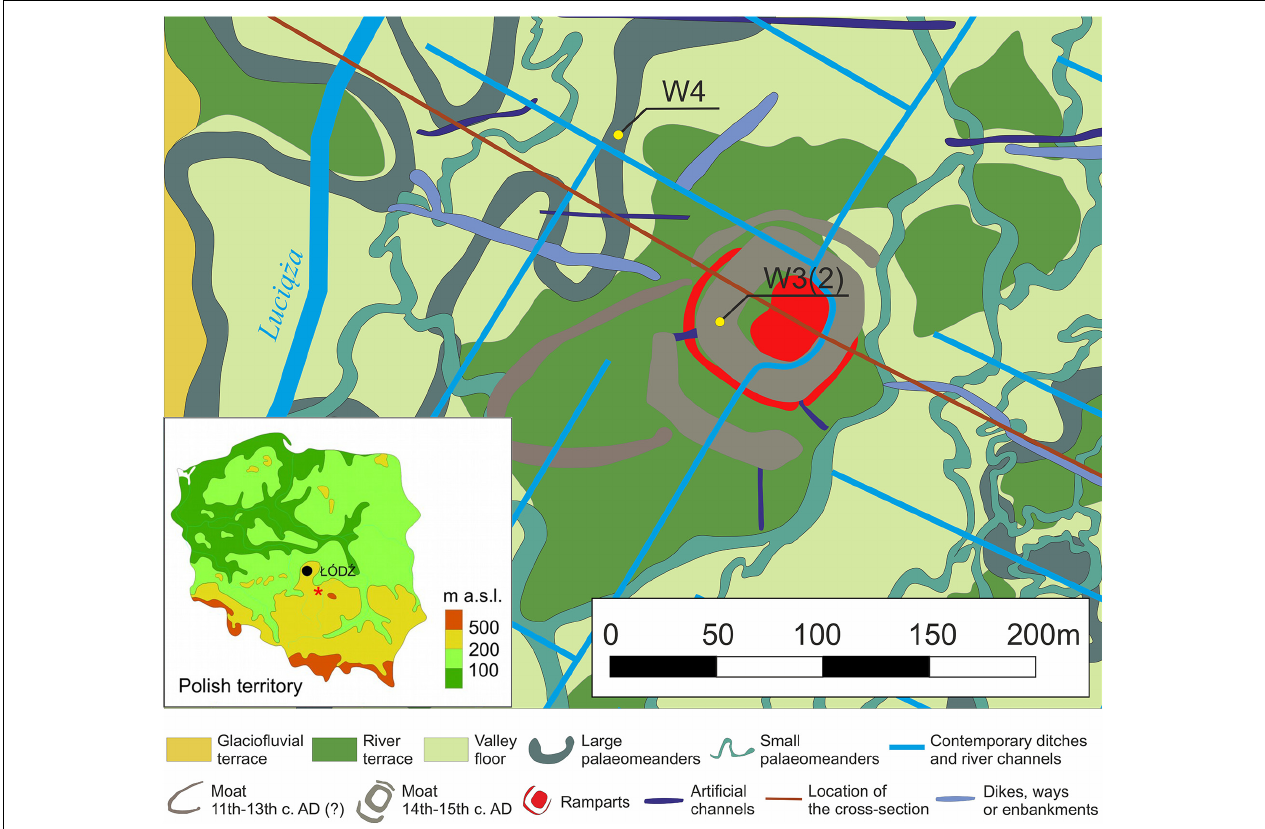
FIGURE 1 | The geomorphological map of the vicinity of Rozprza archaeological site with the location of W4 (paleo-oxbow) and W3(2) (moat) profiles (marked as yellow dots) (after Kittel et al., 2015, 2018b, modified). In the map of Poland, Rozprza is marked with an